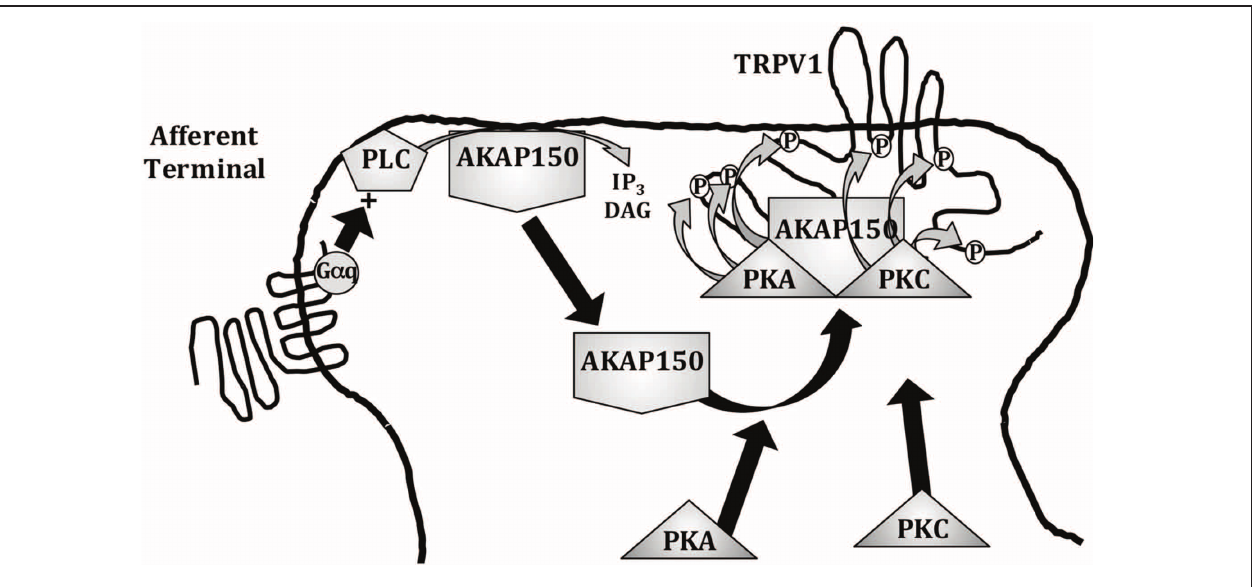
AKAP150 to associate with substrate receptors, such as TRPV1. AKAP150 association with TRPV1 allows for PKA- and PKC-mediated phosphorylation and sensitization of the receptor to peripheral